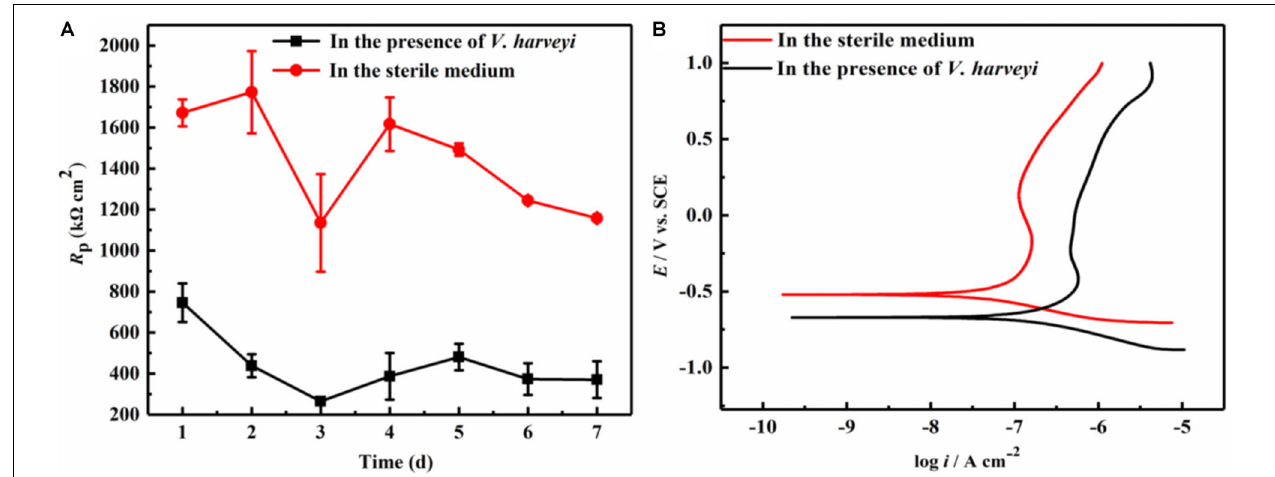
FIGURE 1 | Electrochemical test: (A) Variation of R p values during 7-day immersion, (B) Potentiodynamic polarization curves of AA2024 coupons after 7-day immersion.